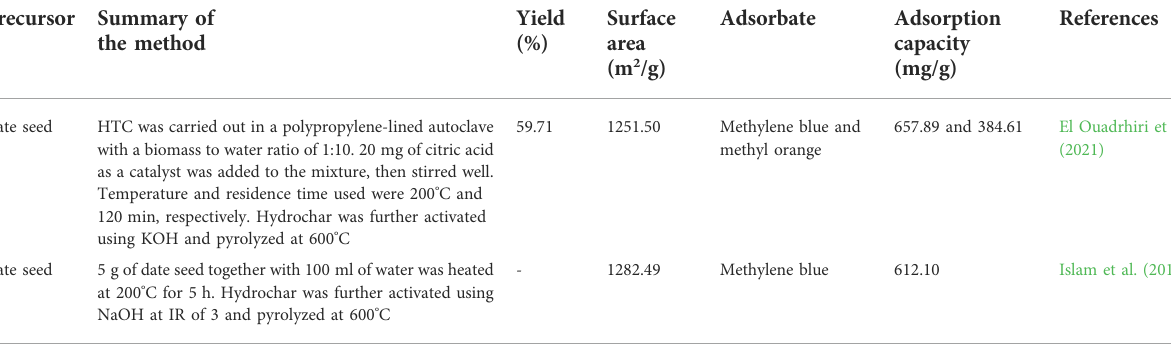
TABLE 6 Summary of works conducted for converting date palm residues into hydrochar via the hydrothermal carbonization